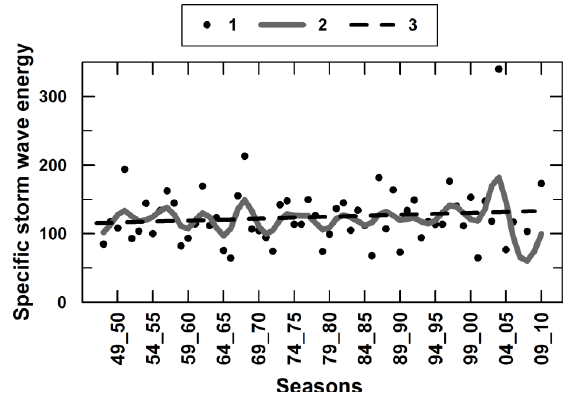
Fig. 13. Variability of specific storm energy during 1948–2010: Figure 13. Variability of specific storm energy during 1948-2010: 1 – data points, 2 – LPF 2 1 – data points, 2 – LPF approximation, 3 – global linear trend approximation, 3 – global linear trend (2.8  10 -6 J.m -2 /decade, R 2 =0.013) 3 (2.8 × 10 − 6 Jm − 2 decade − 1 , R 2 = 0 .